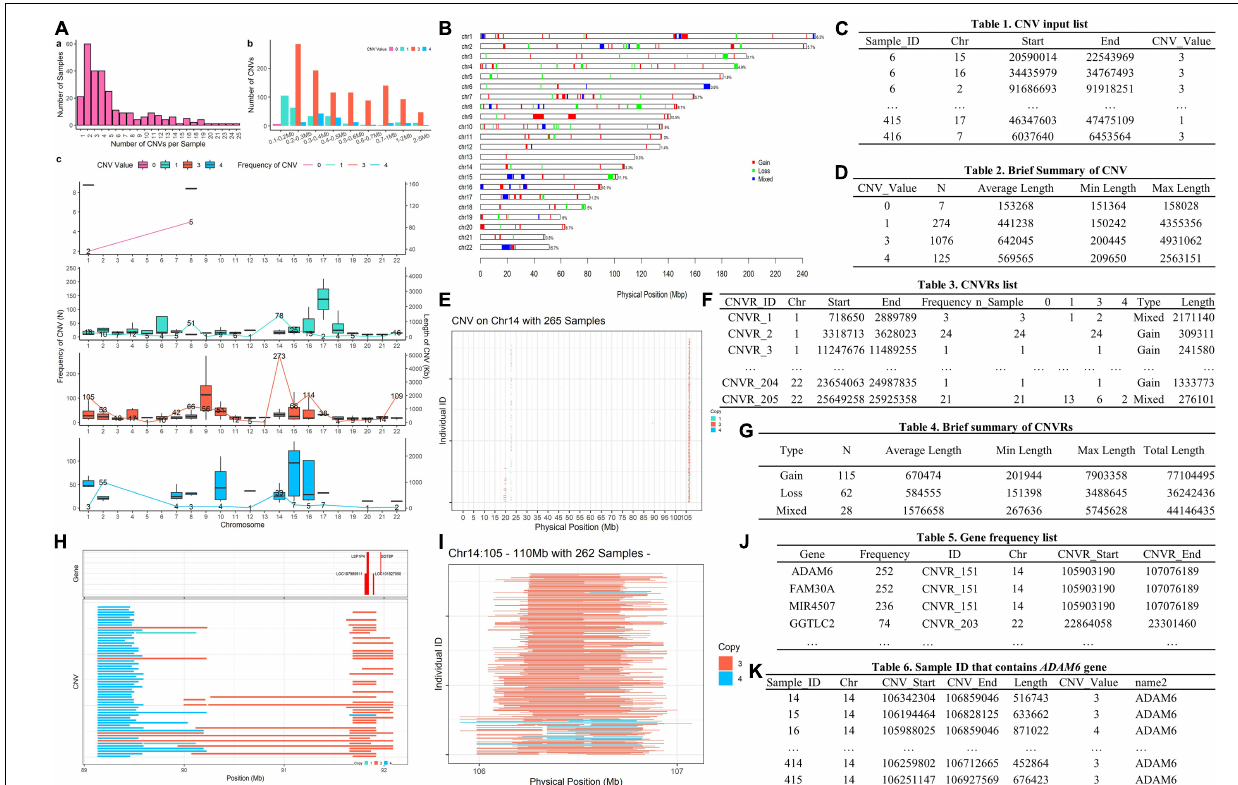
FIGURE 5 | The main outputs of example 1. Panel (A) is CNV summary plot; panel ( B ) is CNVR distribution map; panel (C) is CNV input list; panel (D) is the brief summary table of CNV; panel (E) is a plot of CNVs on Chromosome 14; panel (F) is CNVR list; panel (G) is the brief summary table of CNVRs; panel (H) is an example plot of the high frequency CNVR; panel (I) is a plot of CNVs on Chr14:105-110 Mb; panel (J) is the gene frequency list; and panel (K) is the sample list that contain CNVs in the LINC00221